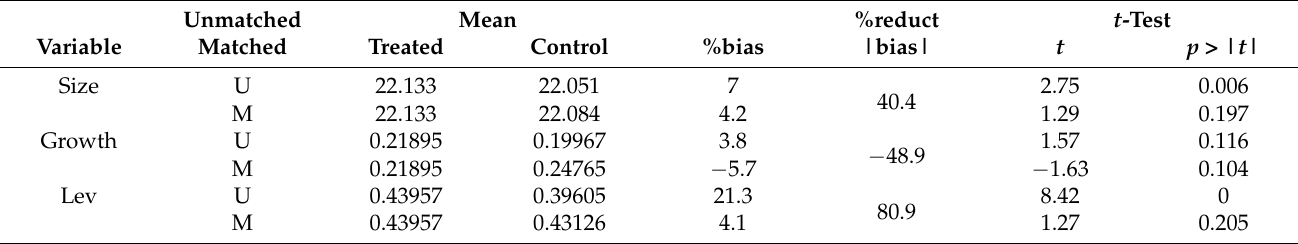
Table A3. Propensity score matching balance